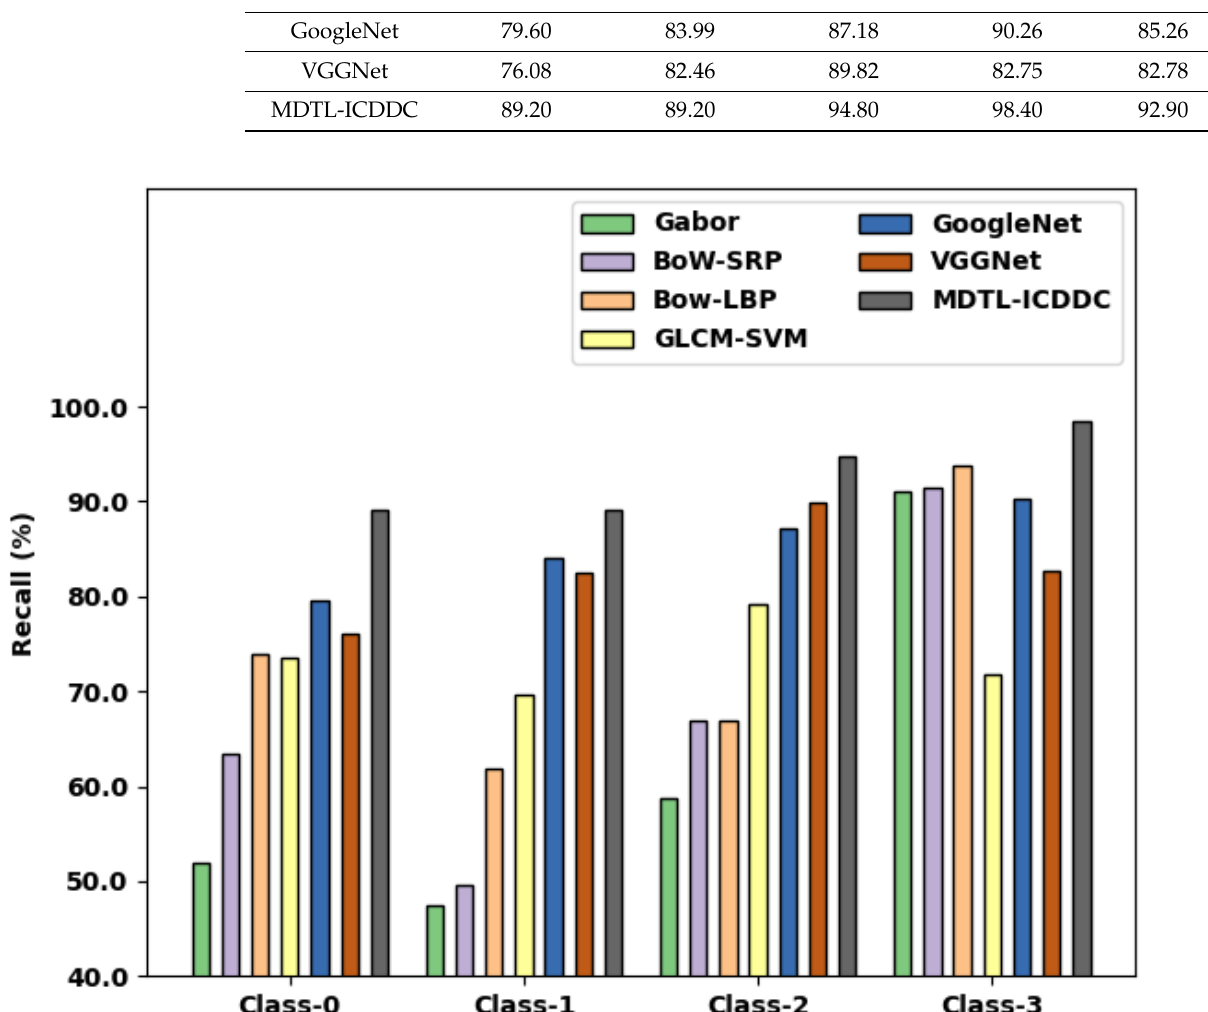
Figure 12. Recall analysis of MDTL-ICDDC technique under various classes.